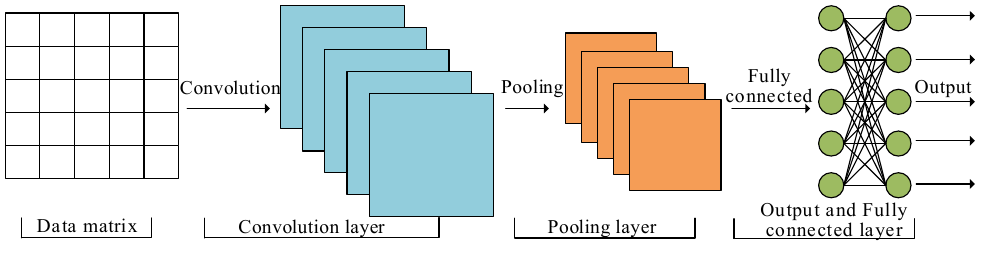
Figure 8. CNN model structure .